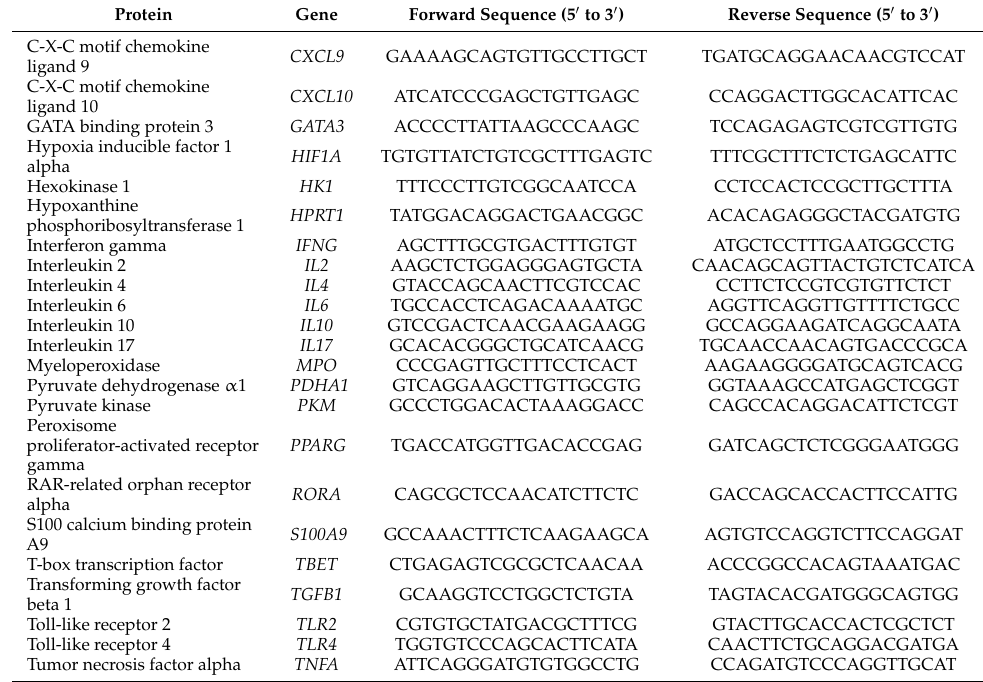
Table 1. List of genes and primers used in gene expression analysis. Protein Gene Forward Sequence (5 (cid:48) to 3 (cid:48) ) Reverse Sequence (5 (cid:48) to 3 (cid:48)